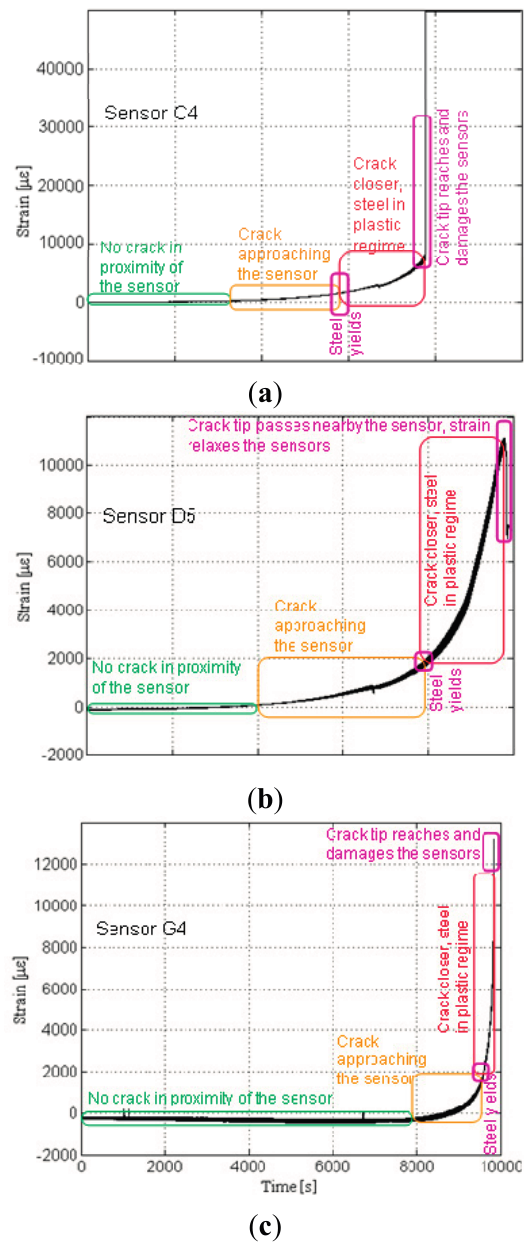
Figure 16. Typical sensor readings, sensors C4, D5 and G4, Plate #4 (Design 1). ( a ) Strain time history of sensor C4; ( b ) Strain time history of sensor D5; ( c ) Strain time history of sensor G4. Note: scale for strain is not the same for the three